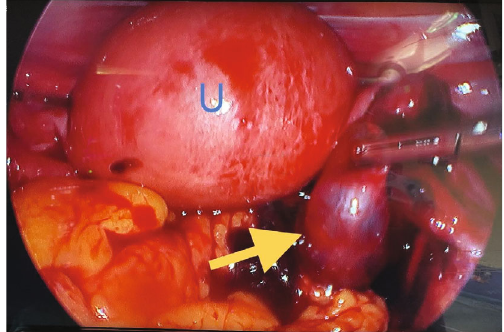
Figure 5: Intraoperative view of an enlarged uterus (U) and enlarged right fallopian tube with a purple-red hue (yellow